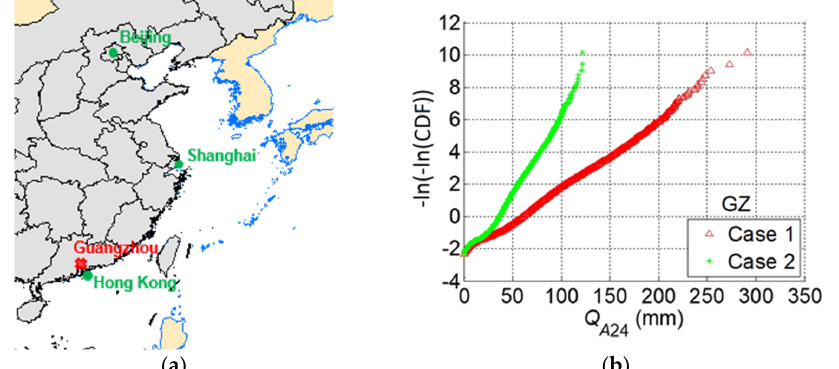
Figure 10. Considered site and empirical distribution of the maximum accumulated rainfall for 24 h: ( a ) considered site and ( b ) empirical probability distribution of Q A 24 presented in the Gumbel probability paper, where the vertical axis represents the value of -ln (-ln(CDF)) in which CDF denotes the value of the (empirical) cumulative probability distribution function (CDF).